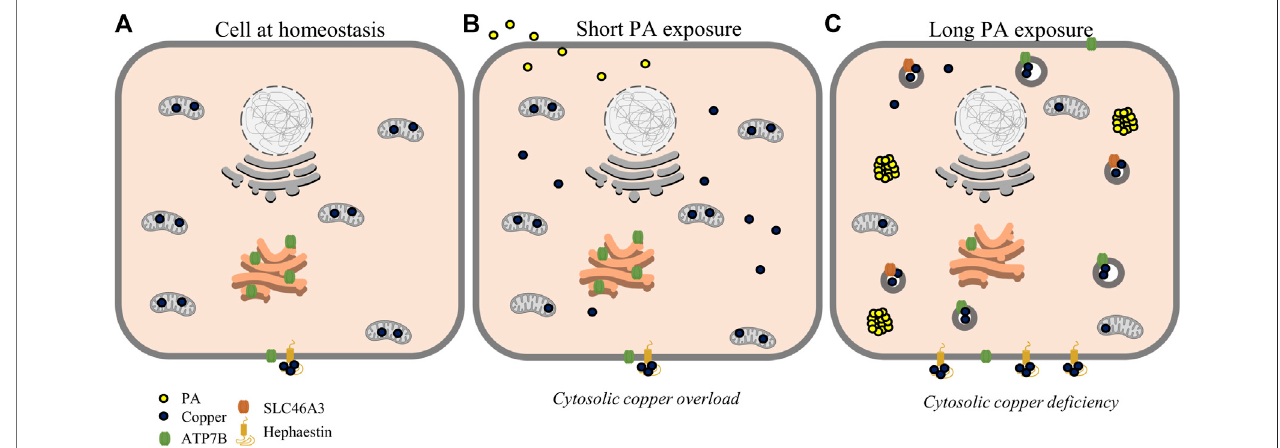
FIGURE 5 | Proposed scheme for possible perturbations of copper homeostasis by PA. At homeostasis (A) , copper is mostly sequestered in proteins and organelles with a large concentration in the mitochondria. At short time points of PA exposure (B) , cytosolic copper levels are increased alongside mitochondrial dysfunction, leading to a state resembling cytosolic copper overload. With longer PA (C) , copper is relocalized toward export by ATP7B and sequestering mechanisms by SLC46A3 and hephaestin resulting in a copper-de fi cient